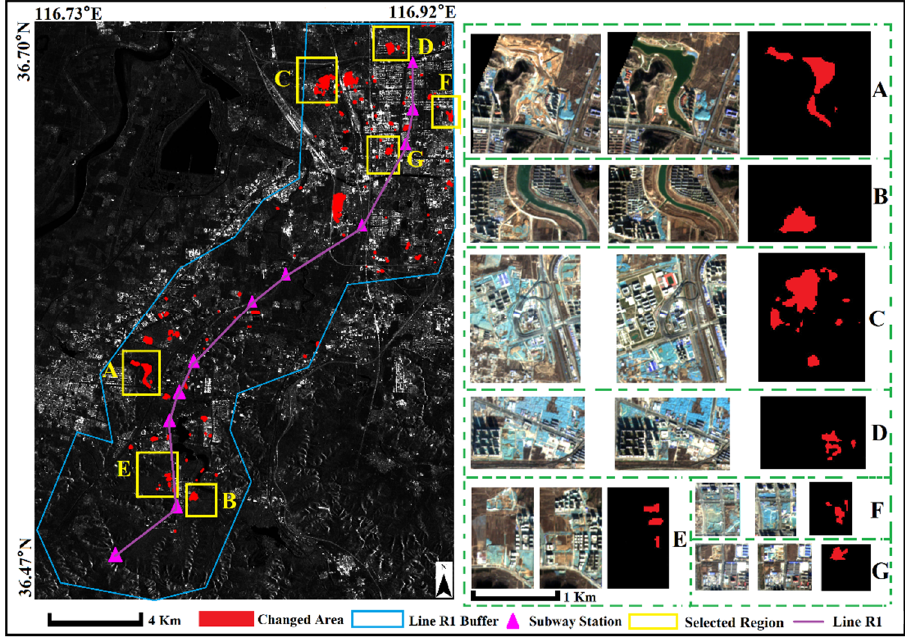
Figure 10. Detection results by LEW method along Jinan Rail Transit Line R1. Note: Regions ( A – G ) represent eight selected regions with different surface changes during the monitoring phase.